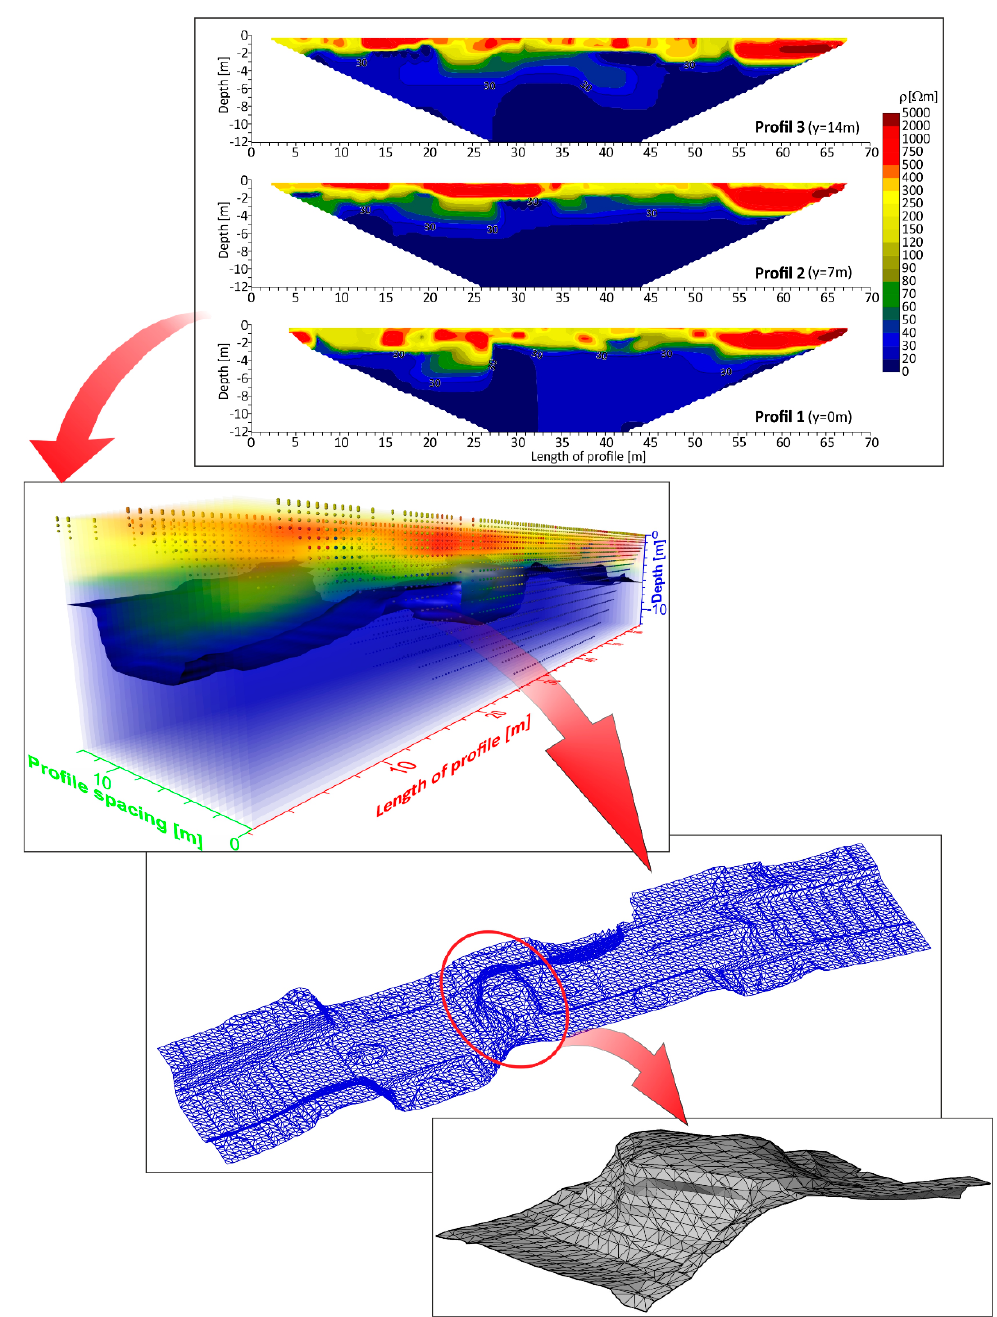
Figure 3. Workflow to select the elevation of the Neogene clay roof surface from the results of quasi 3D electrical resistivity tomography prospection.